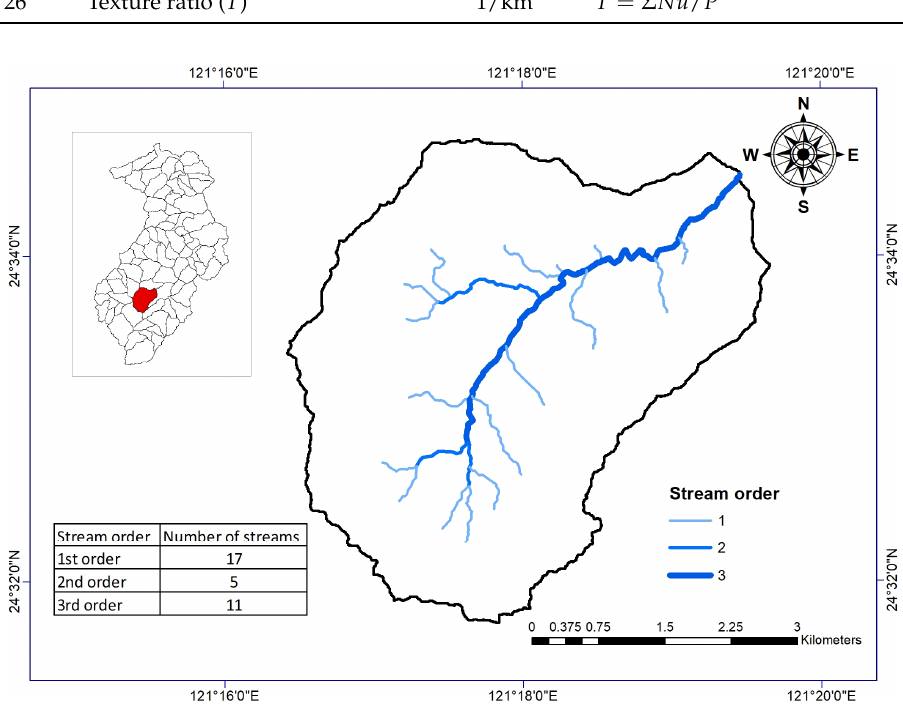
Figure 3. Stream order and the number of streams in a typical subwatershed.